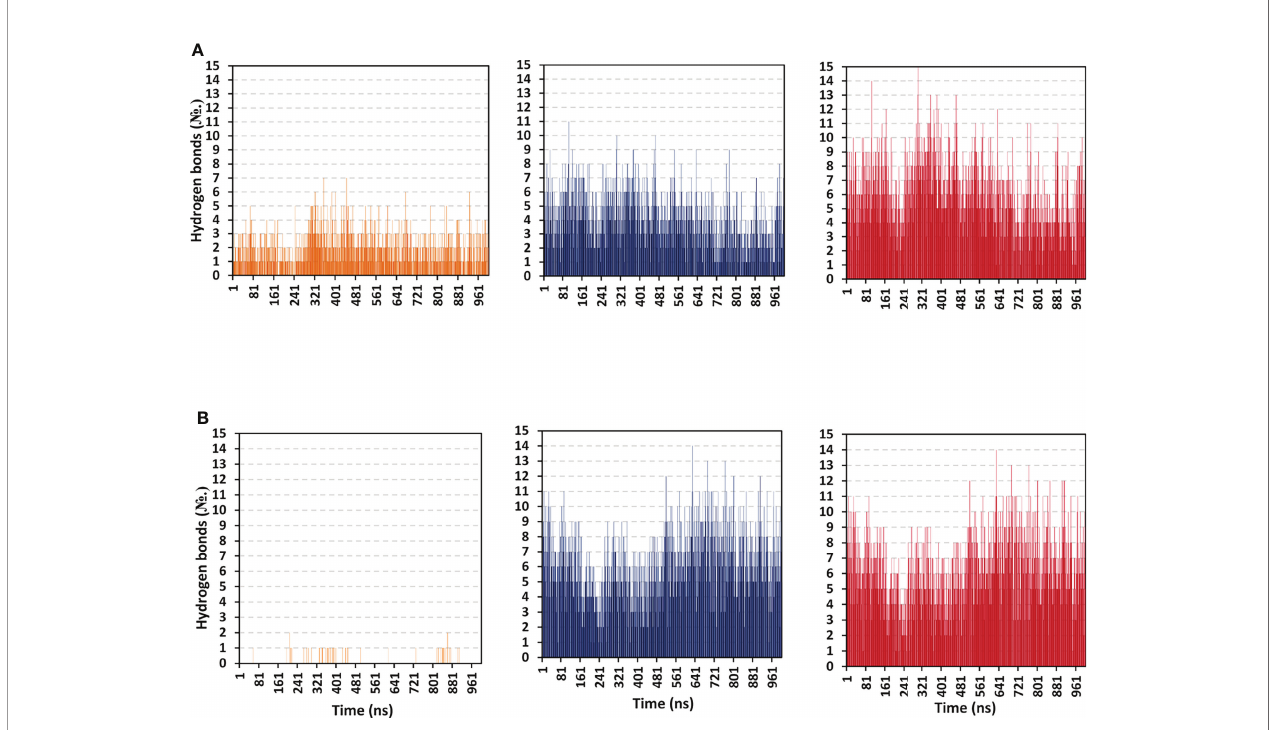
FIGURE 9 | Hydrogen bond number-time evolution within the simulated multiepitope vaccine/TLR models. (A) multiepitope vaccine/TLR-4; (B) multiepitope vaccine/ TLR-8 models. Left, middle and right panels are respective for the vaccine/TLR protomer A, protomer B, and whole target protein